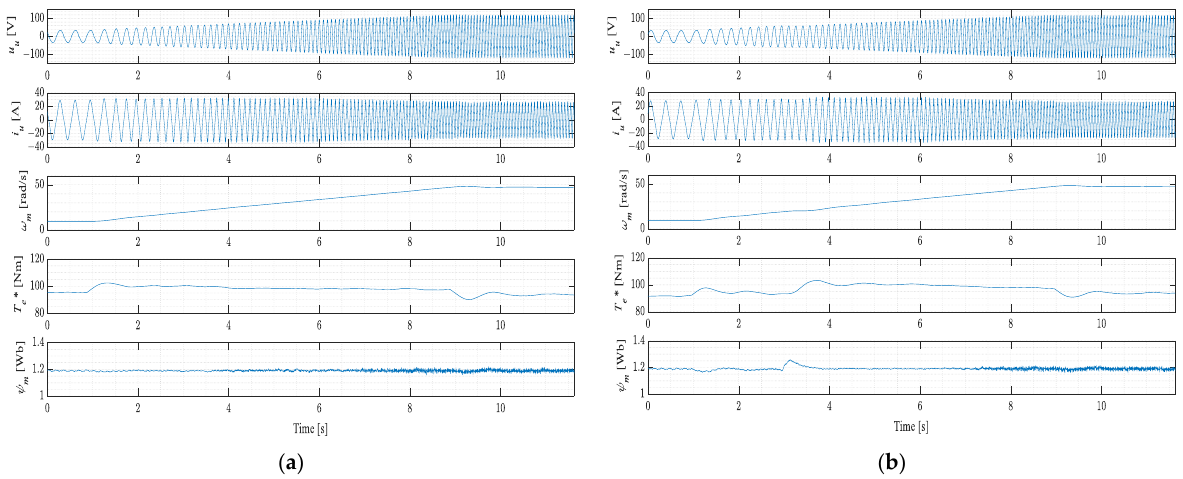
Figure 11. Experimental results of the cycloconverter drive during the machine acceleration with ( a ) Transition based on fuzzy logic set of rules; ( b ) Classical transition.